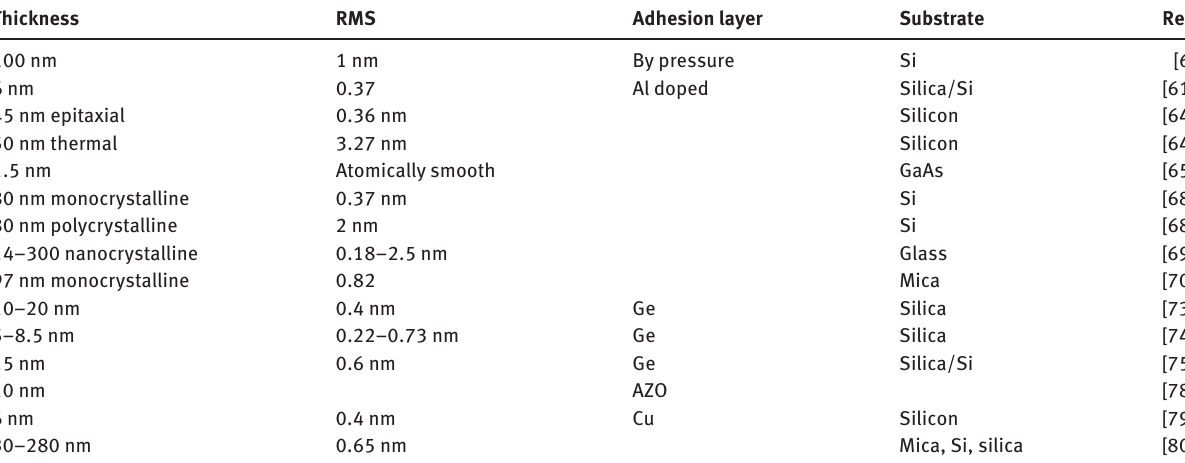
Table 2: Thin Ag film parameters on different substrates and using various adhesion layers. Thickness RMS Adhesion layer Substrate Ref.